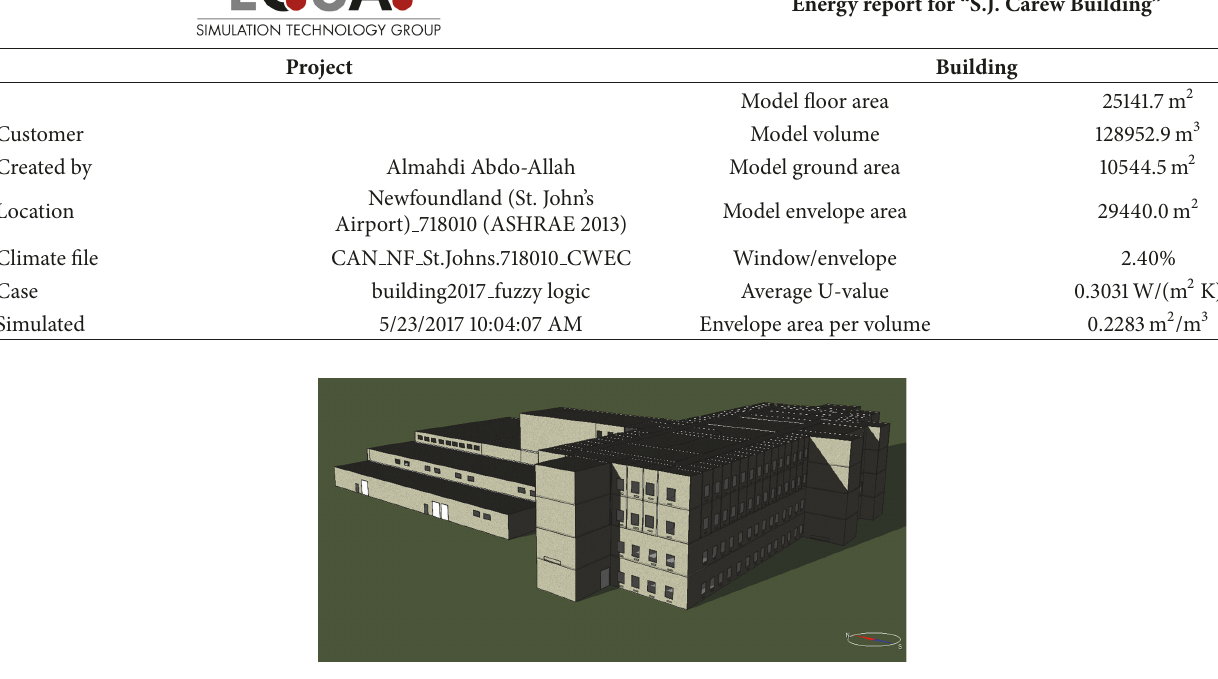
Figure 1: 3D model of S.J. Carew building.